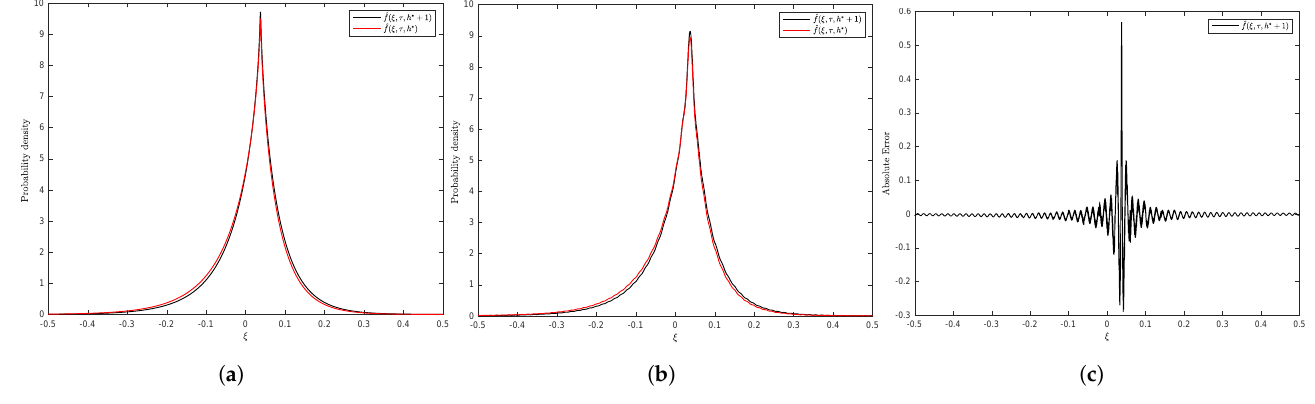
Figure 6. Estimation of ˆ f ( ξ , τ , h ∗ ) versus ˆ f ( ξ , τ , h ∗ + 1 ) , τ = 0.25: ( a ) Newton–Cotes Martingale; ( b ) FRFT Martingale Measure; ( c ) error: FRFT versus Newton.